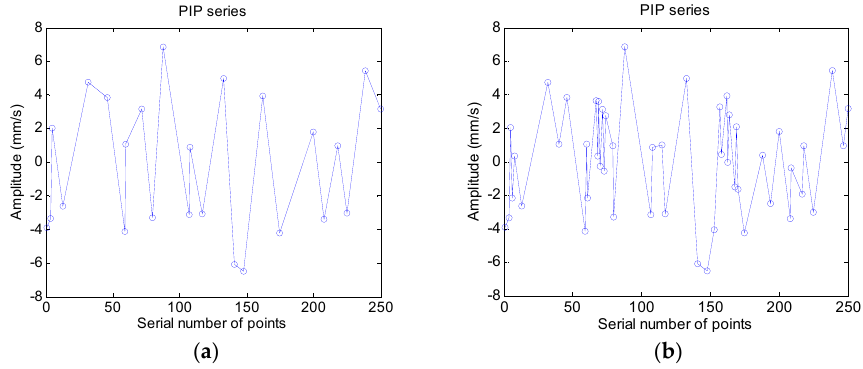
Figure 12. Waveform of PIP series ( a ) PIP series with 25 points; ( b ) PIP series with 50 points.